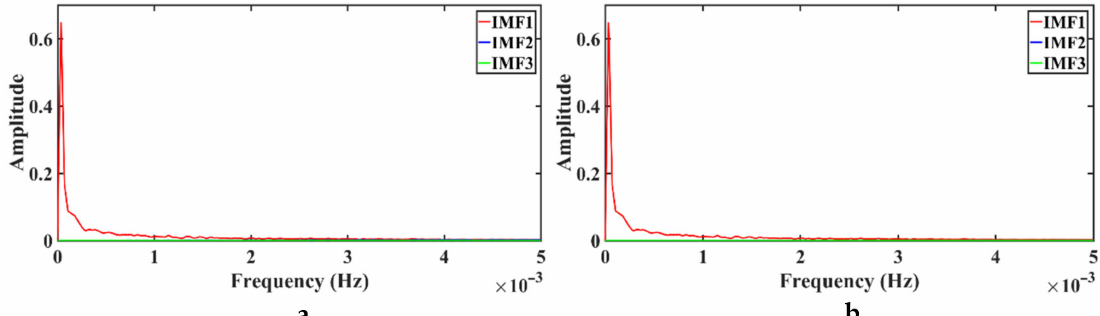
Figure 12. ( a ) IMF1 − IMF3 spectra obtained by the first mode decomposition; ( b ) IMF1–IMF3 spectra obtained by the second variational modal